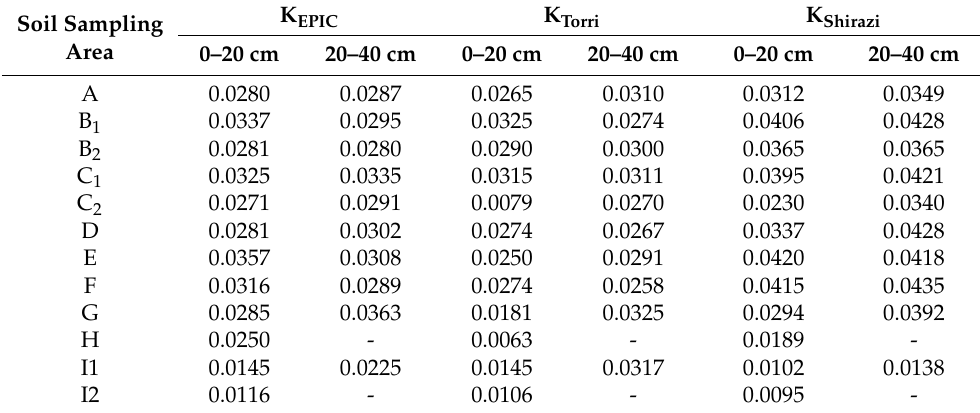
Table 3. K Values simulated by the EPIC model, the Torri model and the Shirazi model. Soil